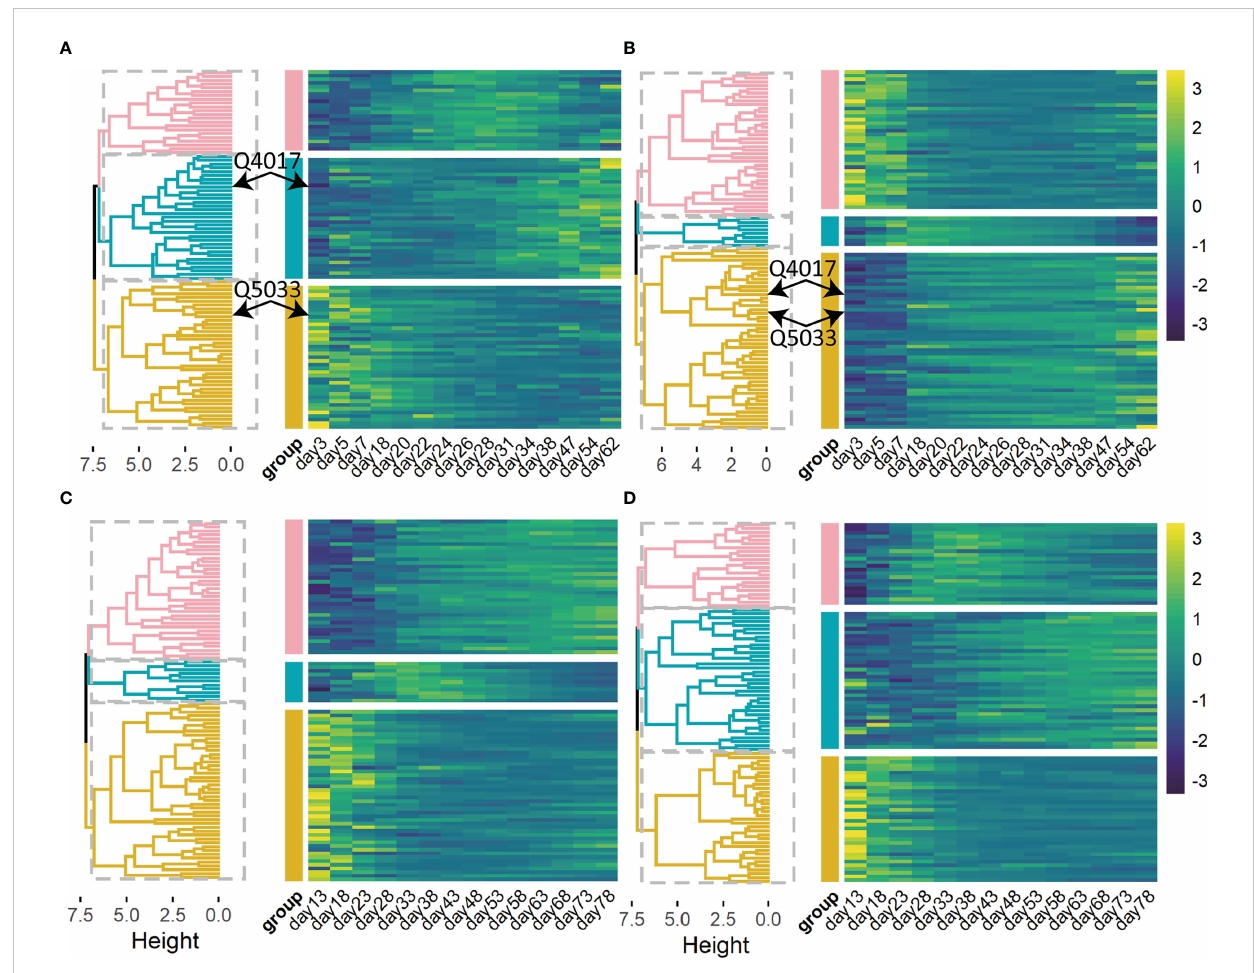
FIGURE 4 Heat maps and hierarchical clustering trees of heritability are explained by 93 signi fi cant QTLs for stem length (A) , taproot length (B) , and 94 signi fi cant QTLs for root number (C) , root length (D) of Populus euphratica , respectively. Heat maps of heritability are explained by several selected QTLs. Signi fi cant QTLs are clustered into 3 categories (pink, green and